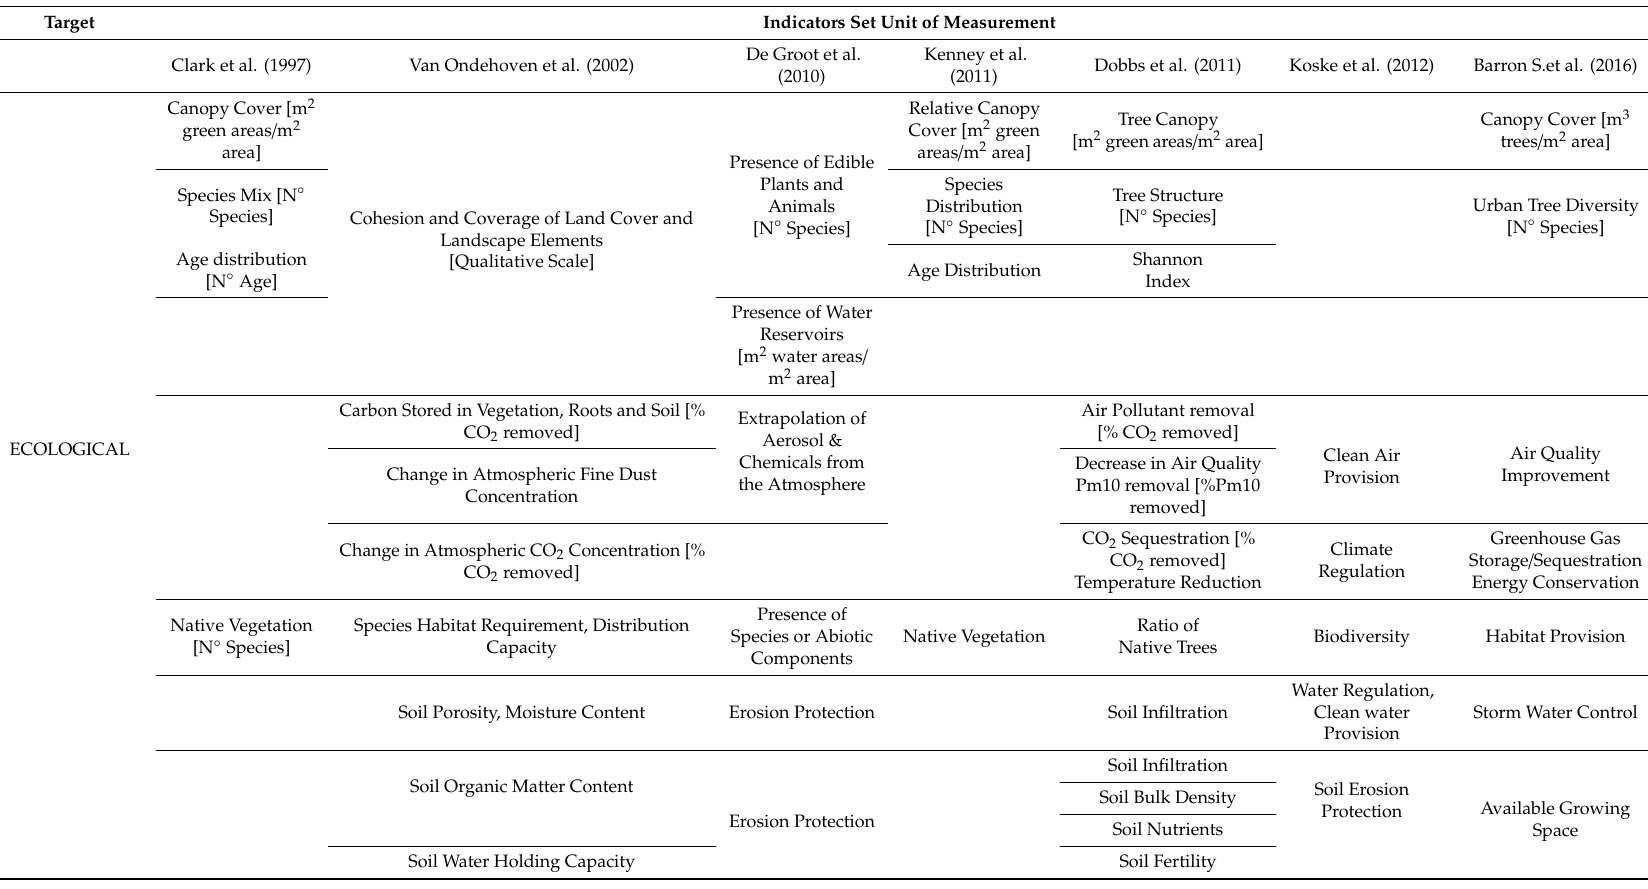
Table 2. Urban forest indicator